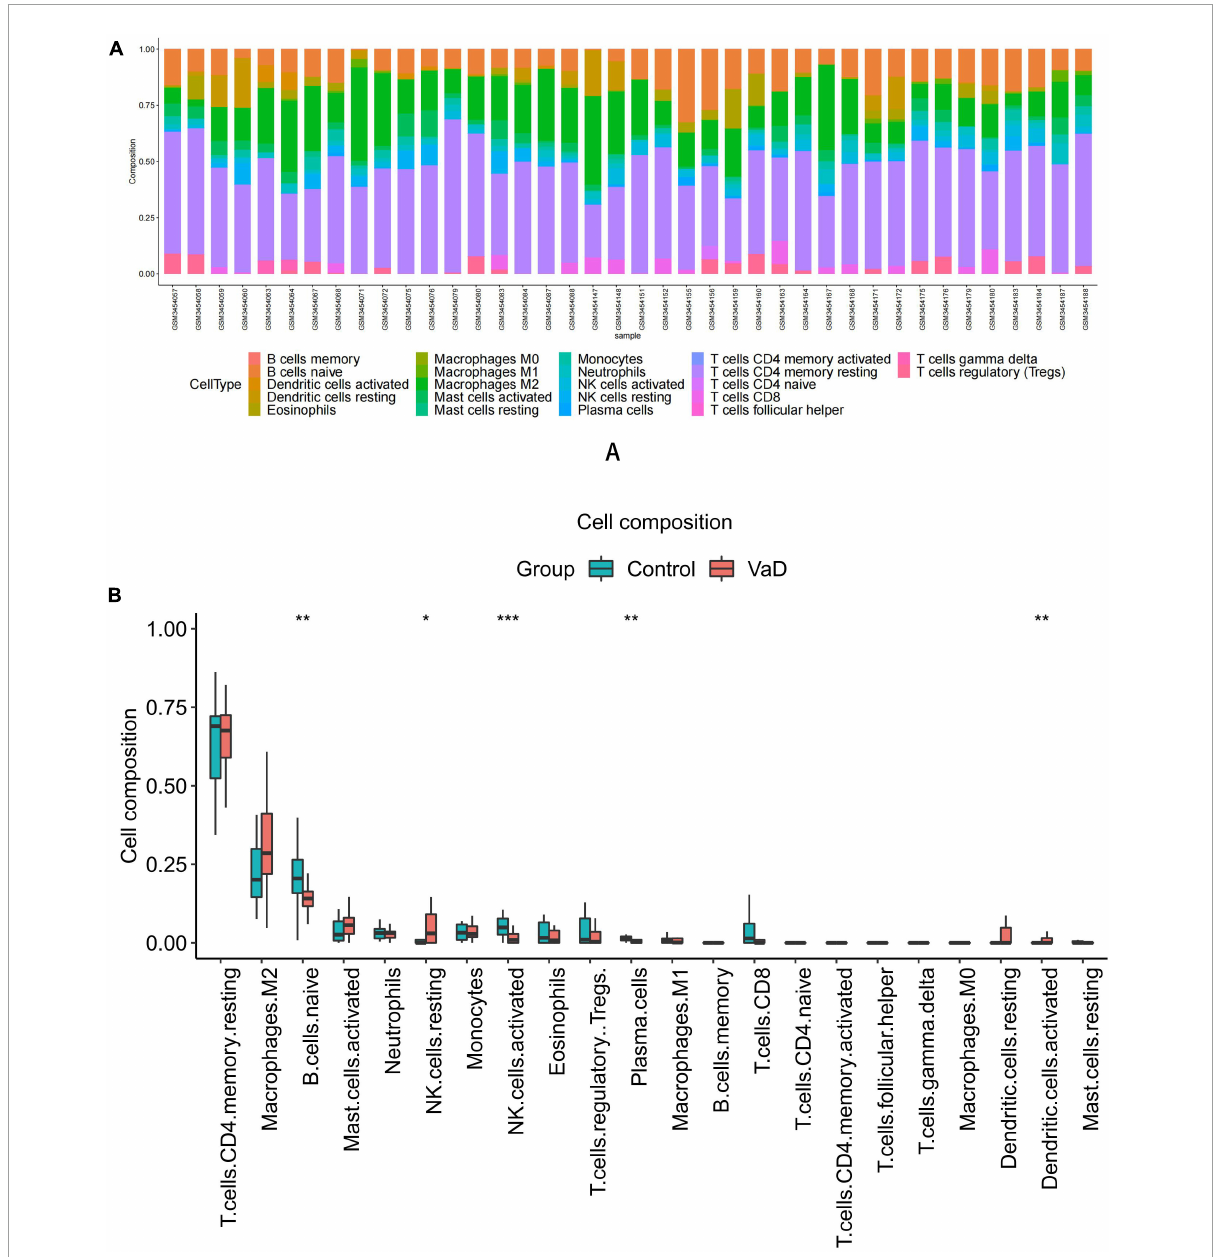
FIGURE5 Immune cell Infiltration and evaluation in vascular dementia (VaD) dataset. (A) Relative proportion of immune infiltration of 22 immune cell types in VaD and matched controls samples. (B) The differential expression of 22 immune cells in the VaD and matched controls samples. Significance level was denoted by * p -value < 0.05, ** p -value < 0.01, *** p -value <